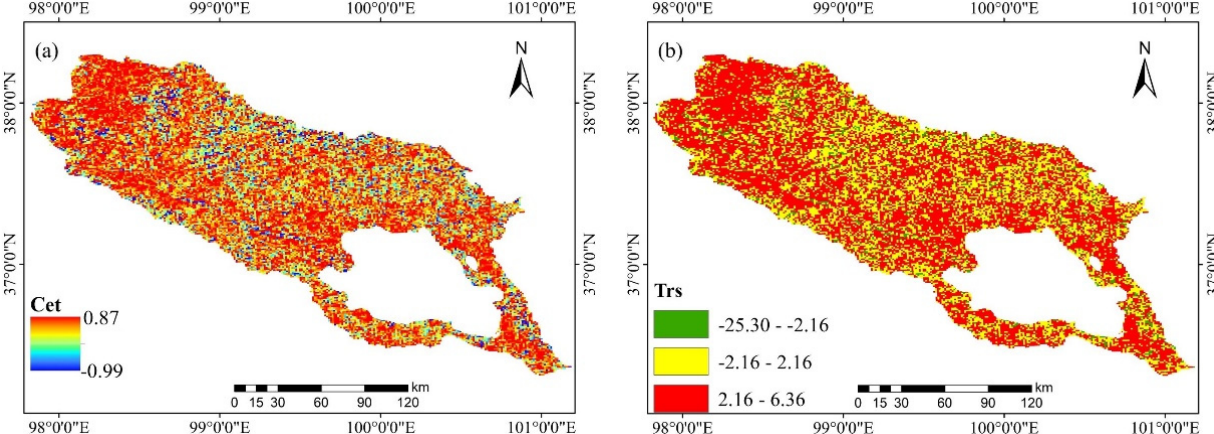
Figure 10. Spatial correlations of NDVI with VWC ( a ) and the t -test results ( b ) in the Qinghai Lake Basin from 2015 to 2020. Cet and Trs represent correlation coefficient and the t-test results, respec- tively.